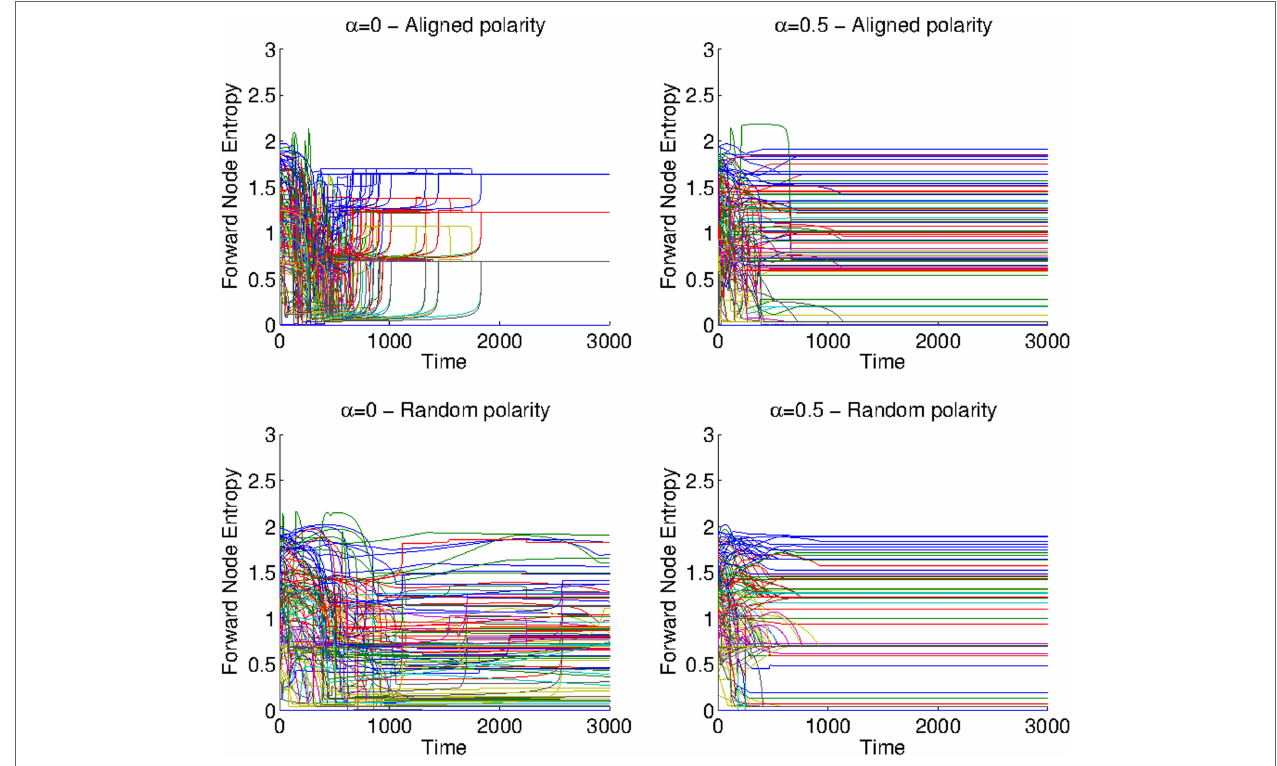
FIGURE 8 | Comparison between simulations without state decay and aligned polarities (top left), only state decay (cid:11) =0.5 (top right), randomized polarities (bottom left), and randomized polarities with state decay (bottom right) . The input voltage is V 0 = 50V. The plots were obtained from plotting all the results from 100 Monte Carlo simulations with similar dynamical parameters but where the initial states have been